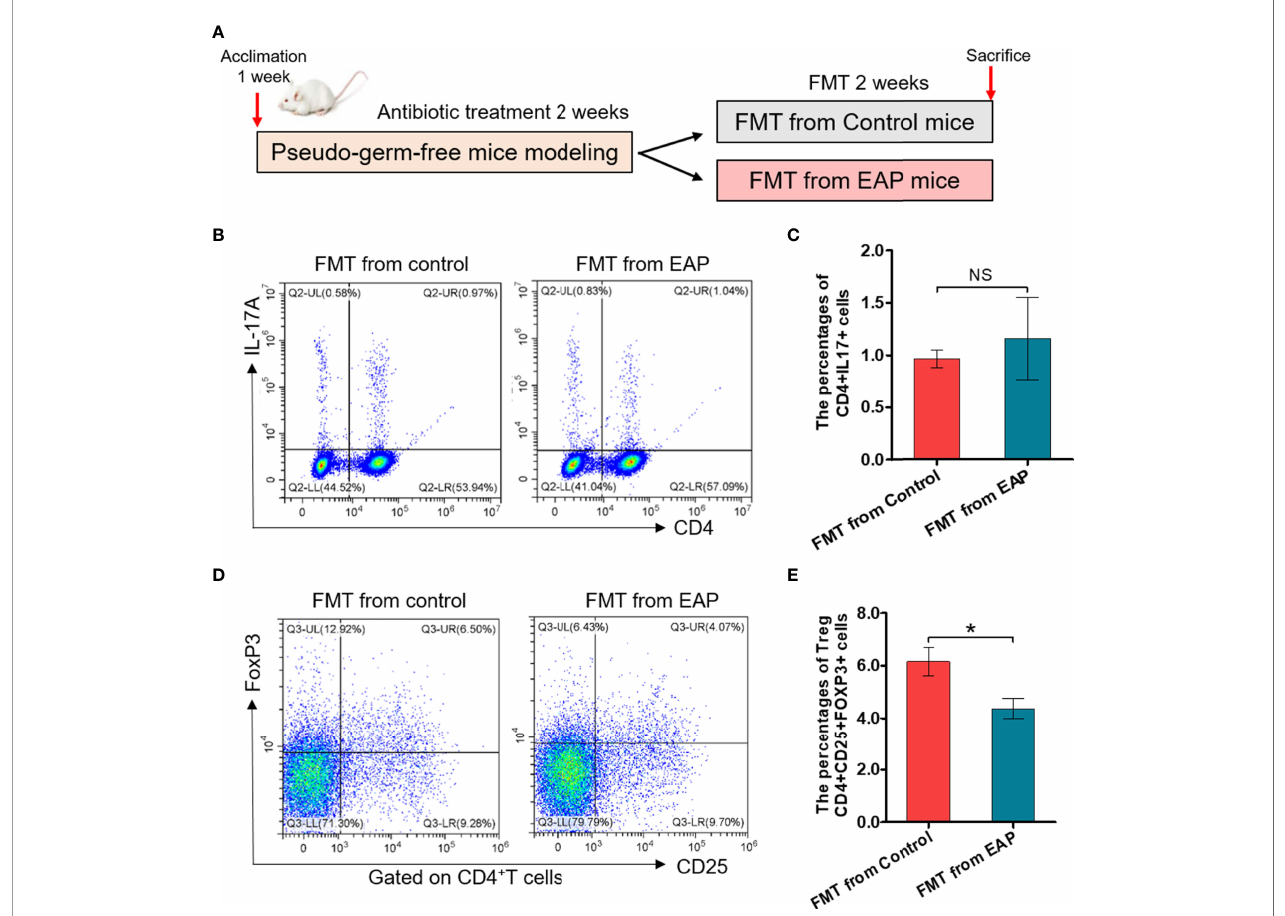
FIGURE 8 | Fecal transplantation from EAP mice induces the decrease of Treg cell frequency in recipient mice. (A) Sketch of the fecal transplantation process. After 1 week of acclimation, mice were treated with antibiotics for 2 weeks. Subsequently, mice received 2 weeks of fecal transplantation from control and EAP mice. All mice were sacri fi ced on day 28, and samples were collected. (B) Representative pictures of fl ow cytometric staining for CD4 + IL-17 + cells in the splenic lymphocytes of mice that respectively received fecal microbiota transplantation from control and EAP mice. (C) Flow cytometric analysis of the proportion of CD4 + IL-17 + cells in recipient mice that respectively received fecal microbiota transplantation from control and EAP mice. (D) Representative pictures of fl ow cytometric staining for CD4 + CD25 + FoxP3 + cells in the splenic lymphocytes of mice that respectively received fecal microbiota transplantation from control and EAP mice. (E) Flow cytometric analysis of the proportion of CD4 + CD25 + FoxP3 + cells in recipient mice that respectively received fecal microbiota transplantation from control and EAP mice. Data are representative of three independent experiments. n = 4 – 5/group; * p < 0.05; NS, not signi fi cant; EAP, experimental autoimmune prostatitis; FMT, fecal microbiota transplantation; IL-17, interleukin-17; FoxP3, forkhead box P3; Treg, regulatory T